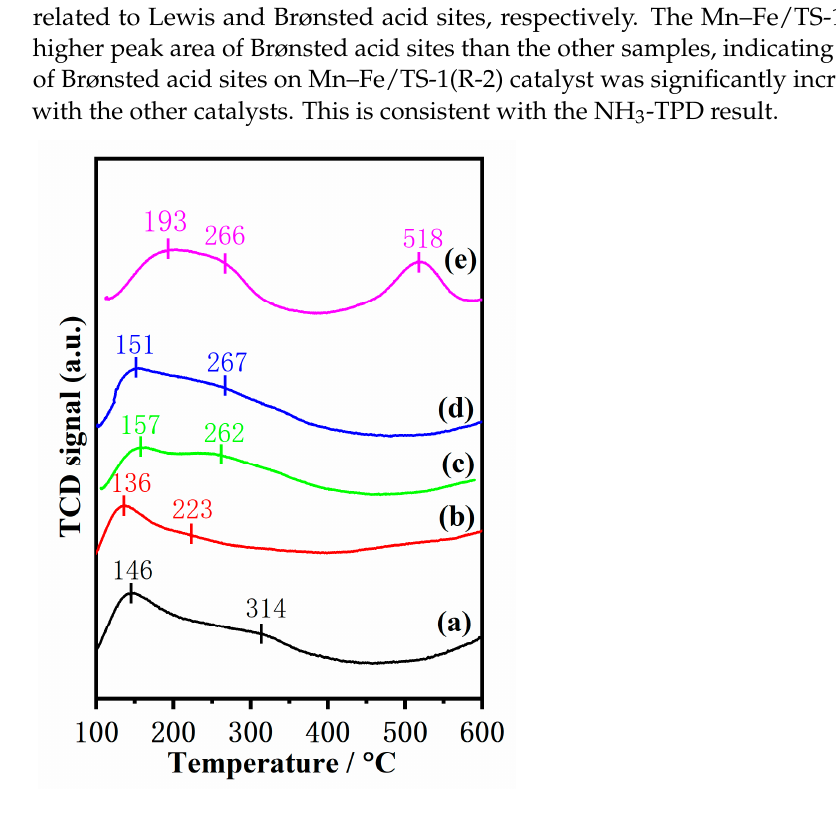
Figure 7. NH 3 -TPD profiles of ( a ) Mn–Fe/TS-1(R-0), ( b ) Mn–Fe/TS-1(R-0.5), ( c ) Mn–Fe/TS-1(R-1), ( d ) Mn–Fe/TS-1(R-2), and ( e ) Mn–Fe/TiO 2 . Table 4. Acid properties of the samples obtained from NH 3 -TPD.